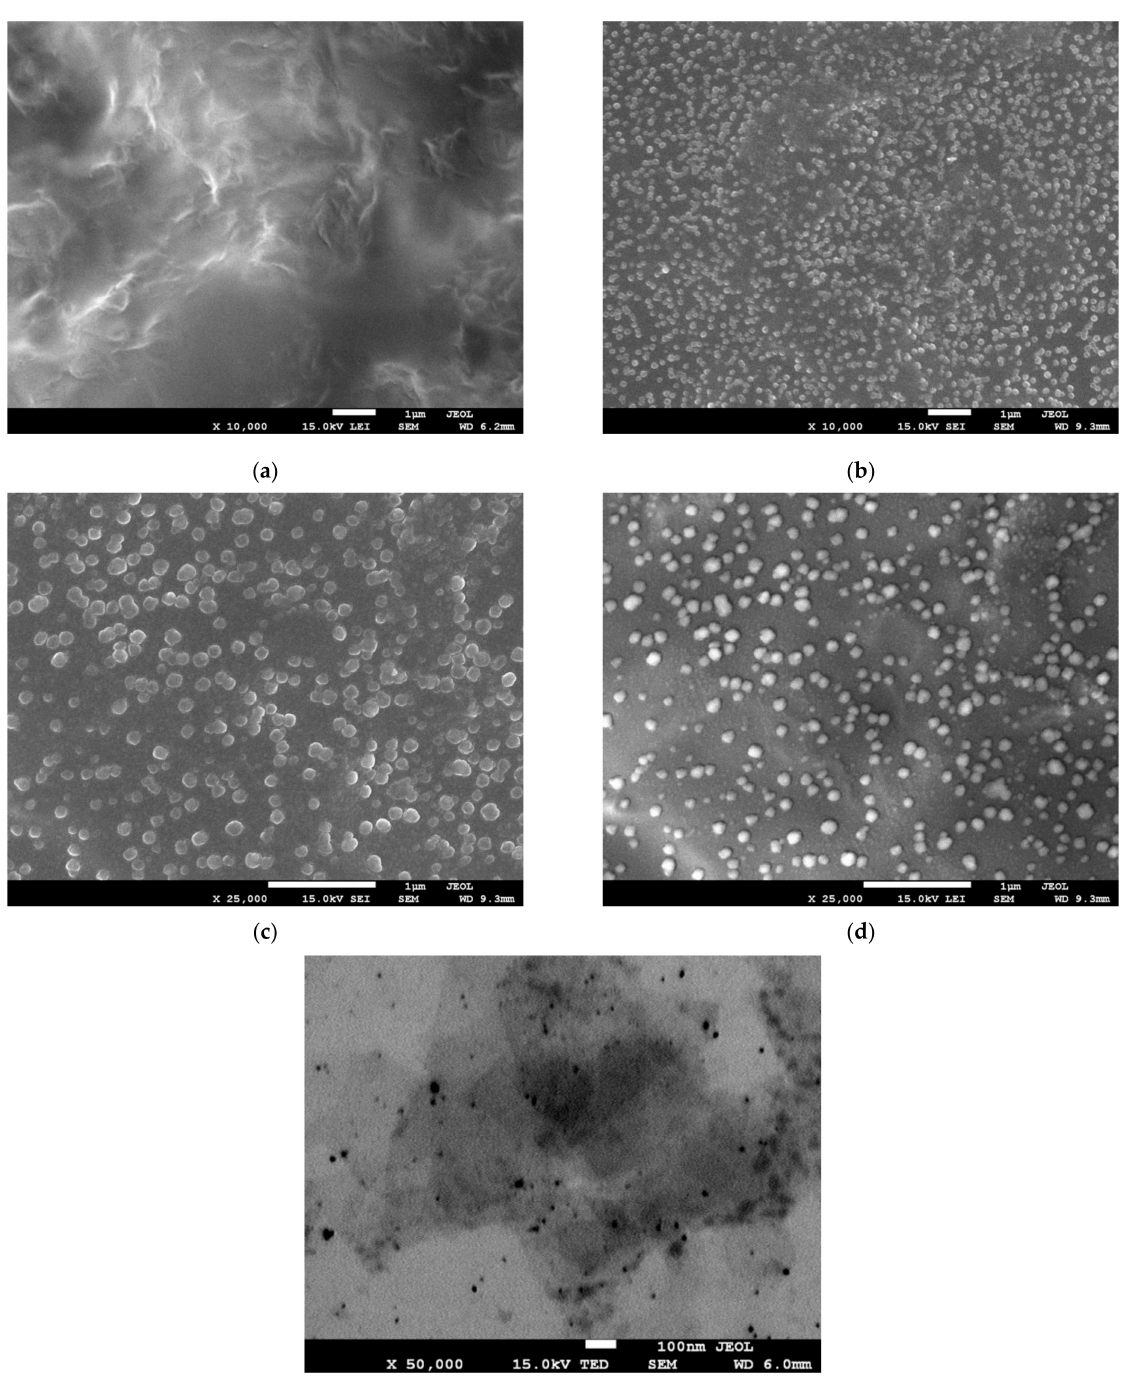
Figure 2. SEM ( a – d ) and TEM ( e ) micrographs of foils taken at different magnifications: ( a ) Hyal/GO; ( b ) Hyal/Ag/GO; ( c ) Hyal/Ag/GO at × 25,000 magnification; ( d ) Hyal/Ag/GO at × 25,000 magnification using secondary electron detection (COMPO system); ( e ) Hyal/Ag/GO at × 50,000